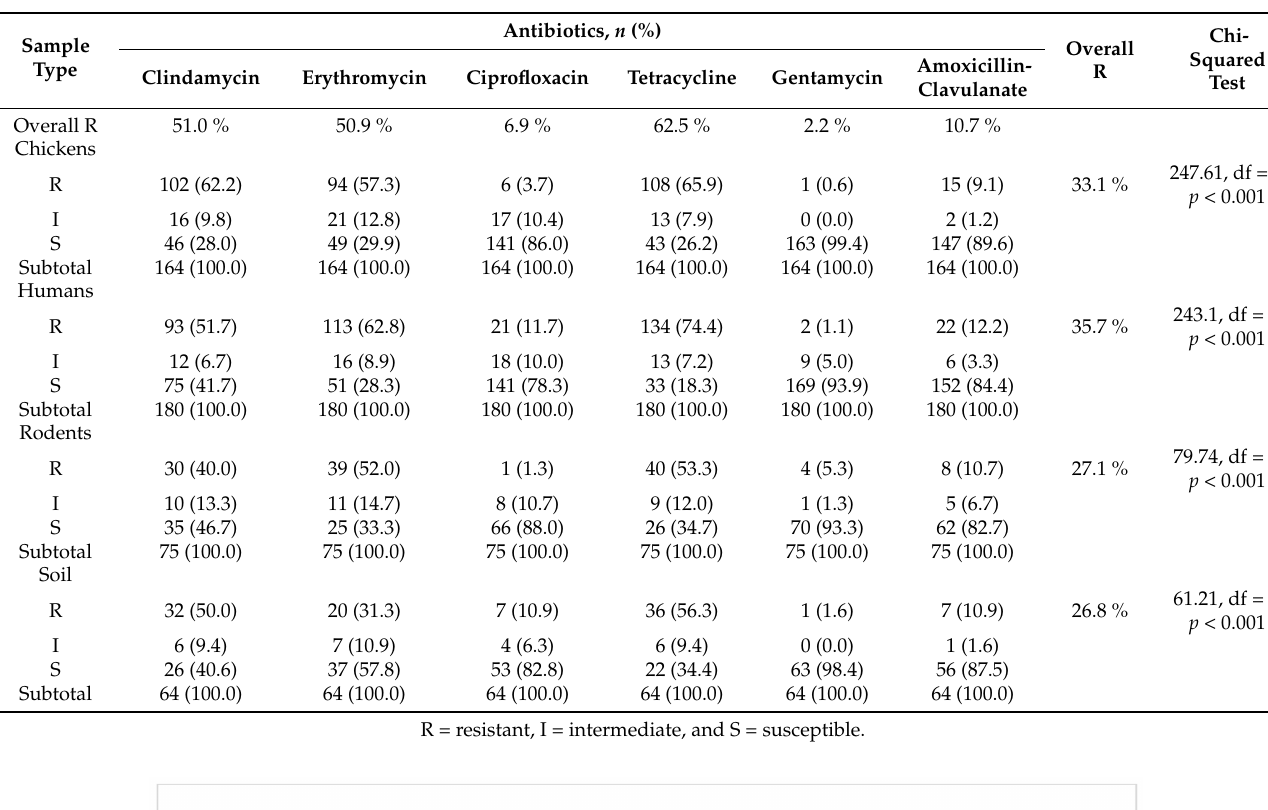
Table 2. Antibiotic resistance pattern of Staphylococcus aureus isolates from chicken, human, rodent, and soil samples.